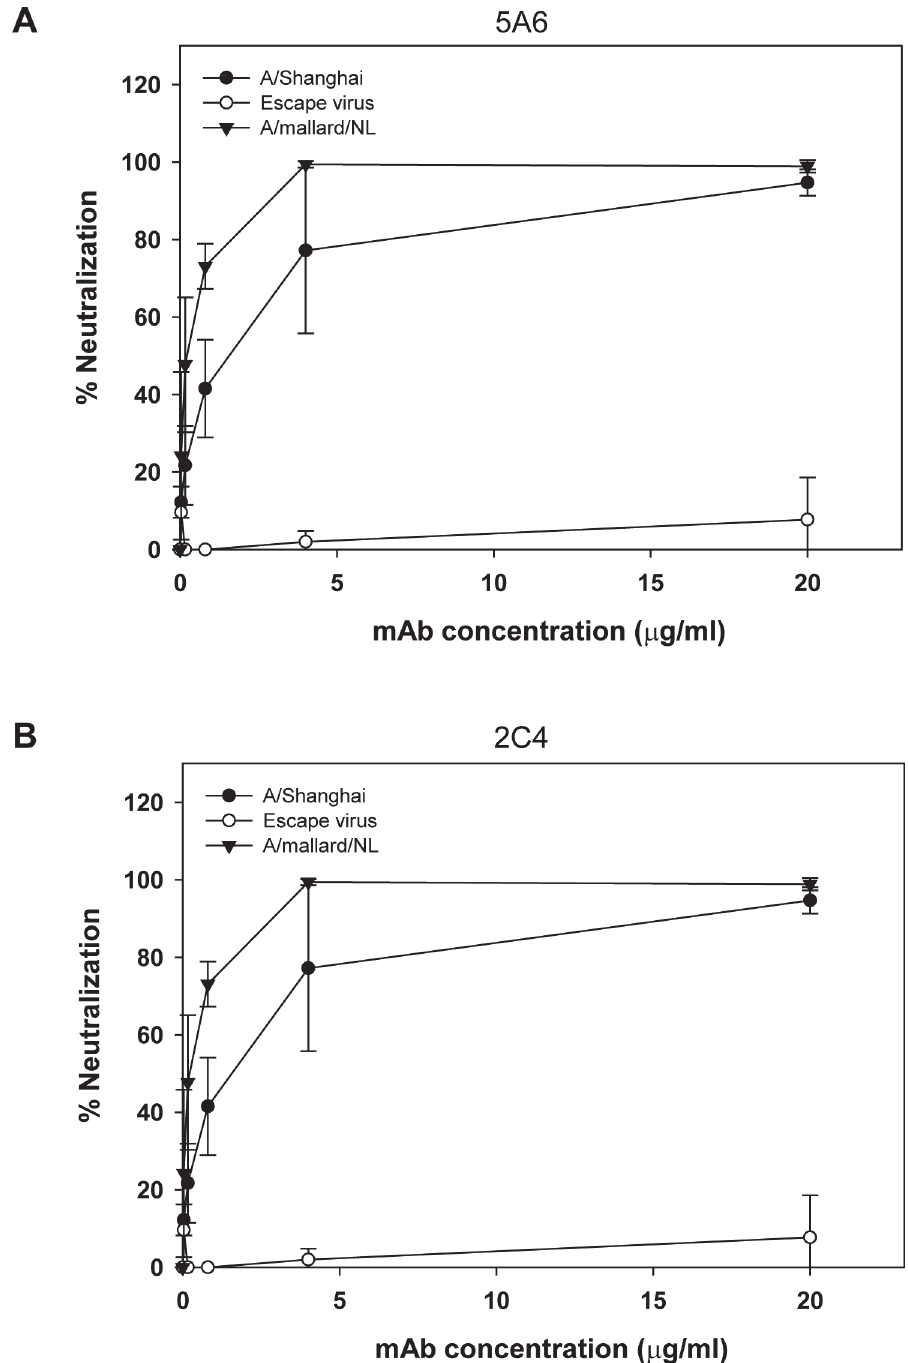
Figure 2. Plaque-reduction neutralization of H7 viruses with H7 mAbs. A/Shanghai/2/2013, A/Shanghai R131G escape virus, and A/mallard/Netherlands/12/2000 H7N3 were incubated with the indicated concentrations of mAb 5A6 (A) or 2C4 (B) before infection of MDCK cells to determine neutralization. Data are the average (mean) of two replicate experiments.